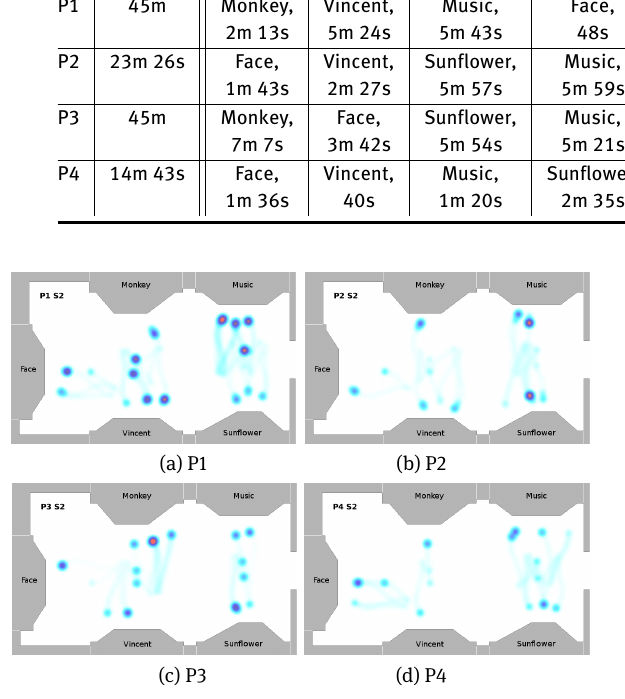
Fig. 11. Heatmap of the robot’s movements within each exhibit area during the second in-robot gallery visitation (S2) for each partic- ipant; movement between exhibits is not shown. In each image, the Face exhibit is the leftmost, then the Monkey, Music (new), Sunflower (new), and Vincent exhibits moving in the clockwise di- rection. The heatmaps depict the amount of time the robot spent moving within each exhibit area, specifically from an exhibit’s main entry pose and its 4 hotspots ( left , center , right , and info ).